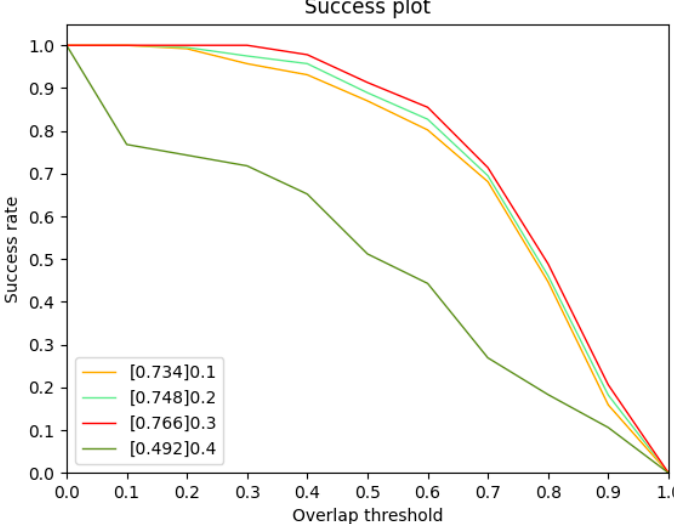
Figure 7. Success plot on every threshold. The values in legends are the AUC.